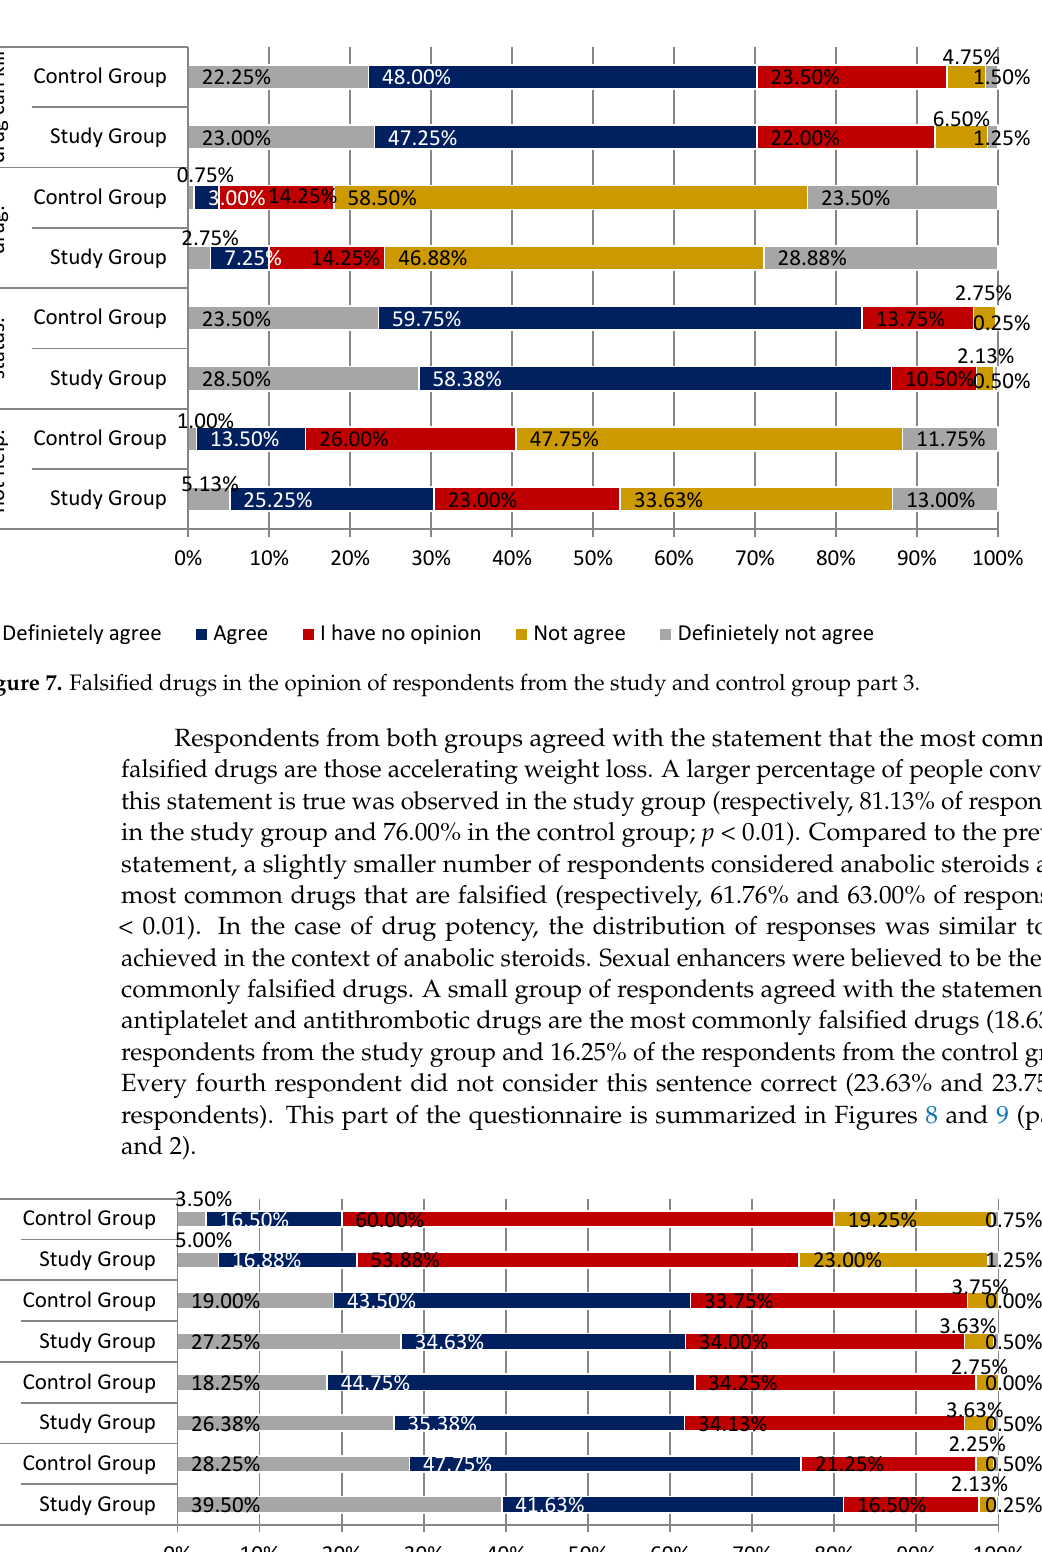
Figure 6. Falsified drugs in the opinion of respondents from study and control group part 2.